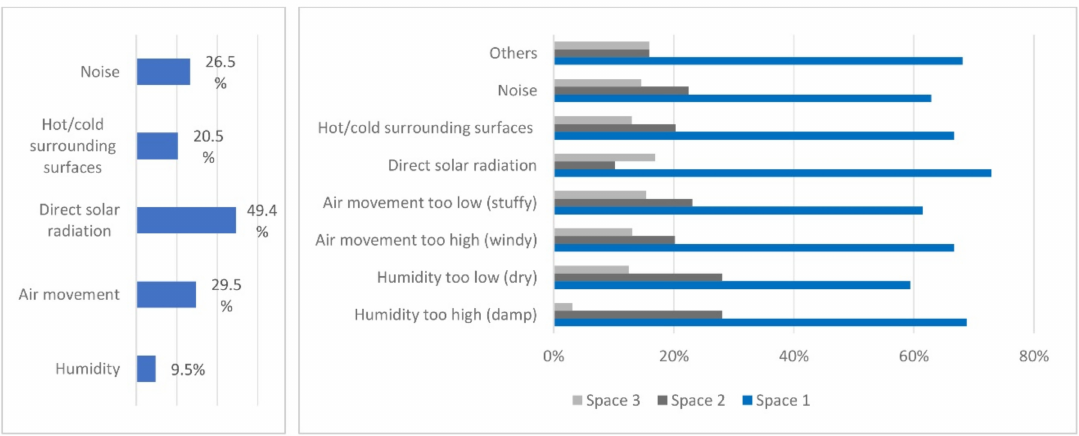
Figure 15. Respondents’ opinions about the discomfort features of the open